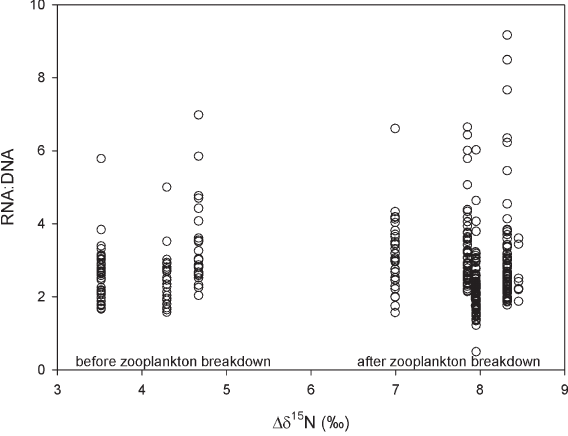
basis versus the corresponding mean RNA:DNA ratio of the larvae. The solid line is the regression line for